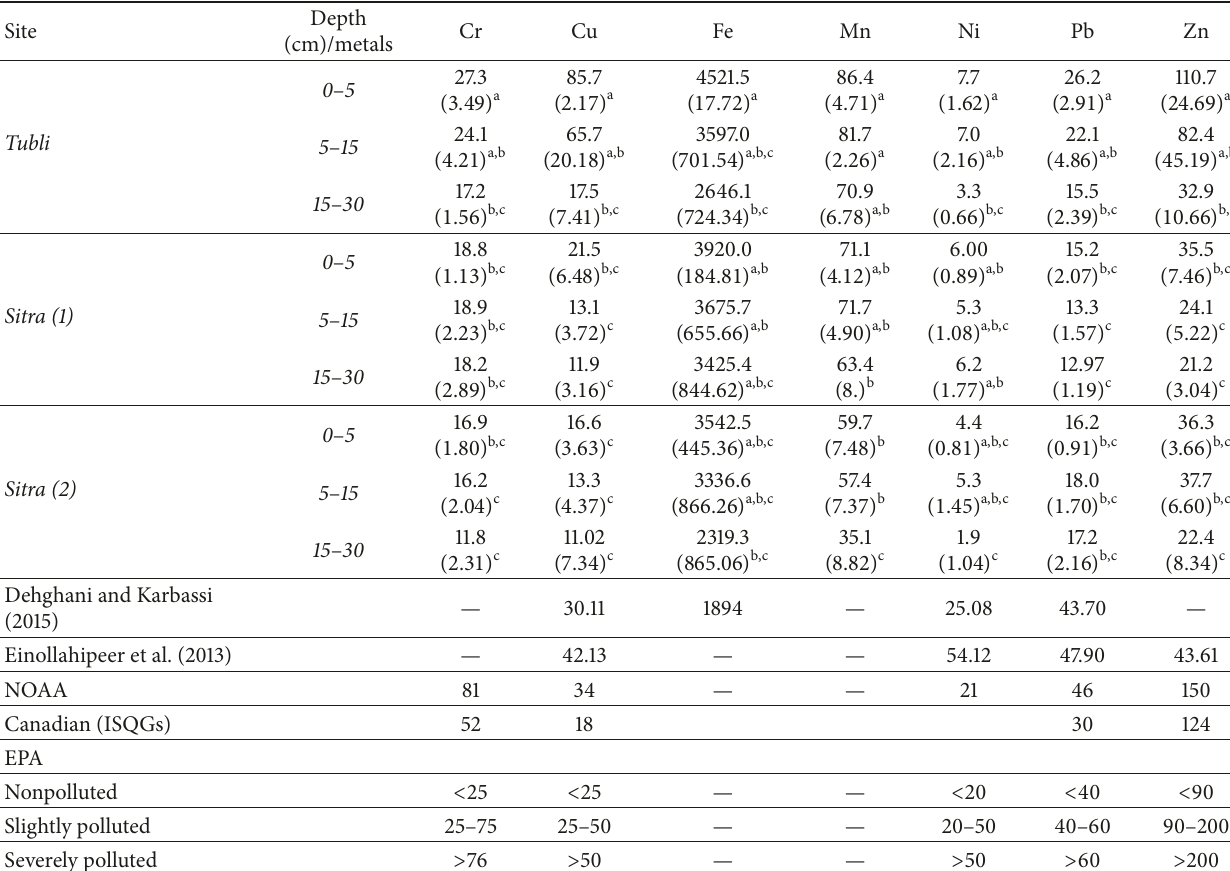
Table 2: Mean concentrations of heavy metals in mgL −1 ( ± SEM) ( 𝑛 = 6 ) in the sediment of gray mangrove ( mg L −1 ) ∗